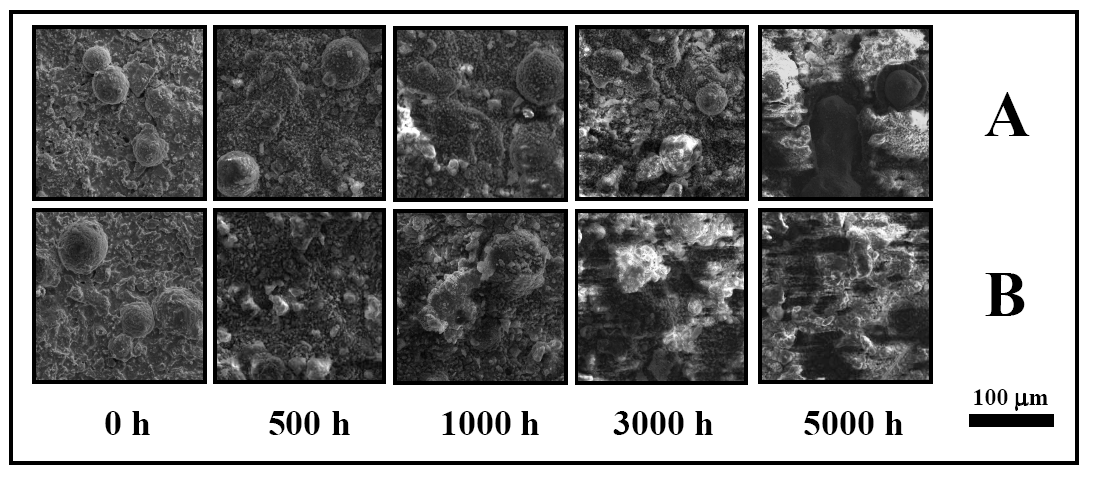
Figure 9. SEM micrographs showing the morphology evolution of the surface of samples A and B before and after different periods of oxidation at 1,273 K.